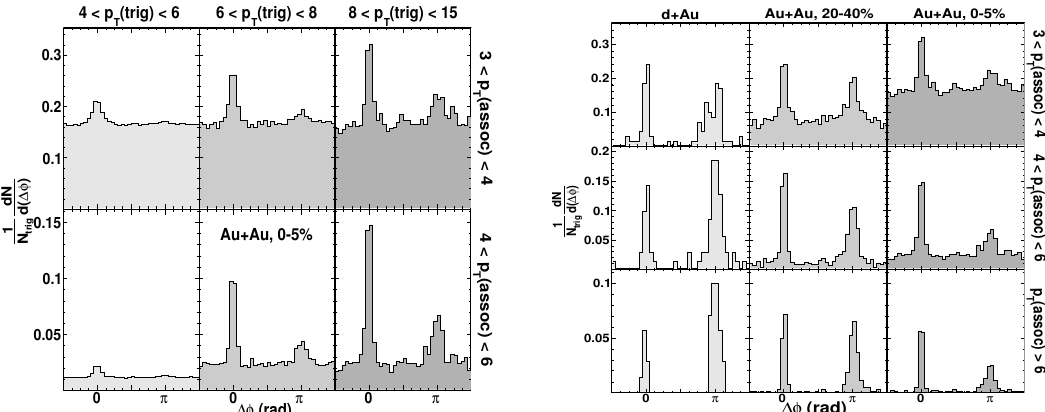
Figure 23. Left : Azimuthal correlation histograms of high- p T charged hadron pairs normalized per trigger particle for 0%–5% Au + Au events for various p trig left panel is suppressed due to the constraint p assoc GeV/ c , for d + Au, 20%–40% Au + Au and 0%–5% Au + Au events. Reproduced from Ref.